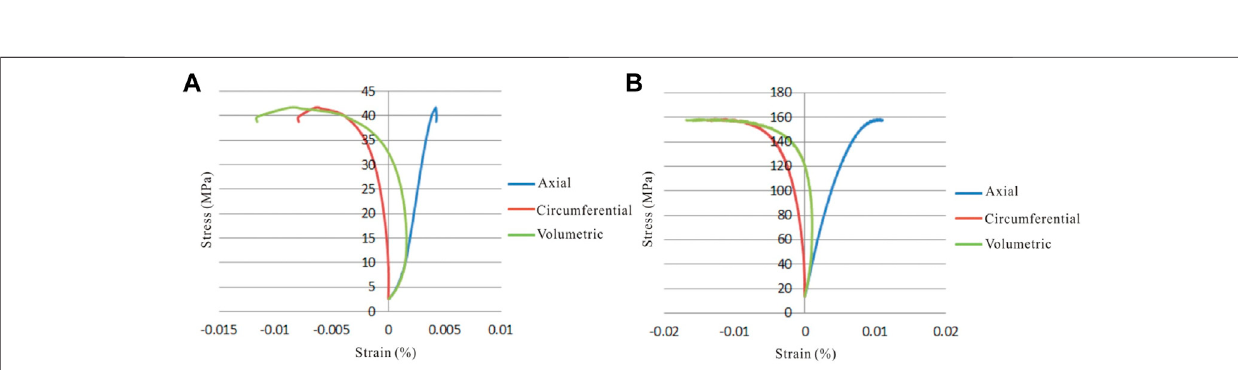
Frontiers in Earth Science |